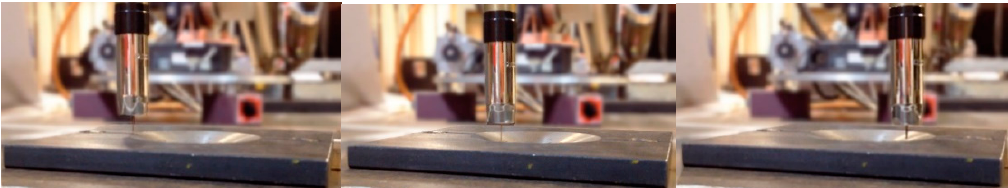
Figure 19. Positioning measurements along a trajectory crossing the metallic block.